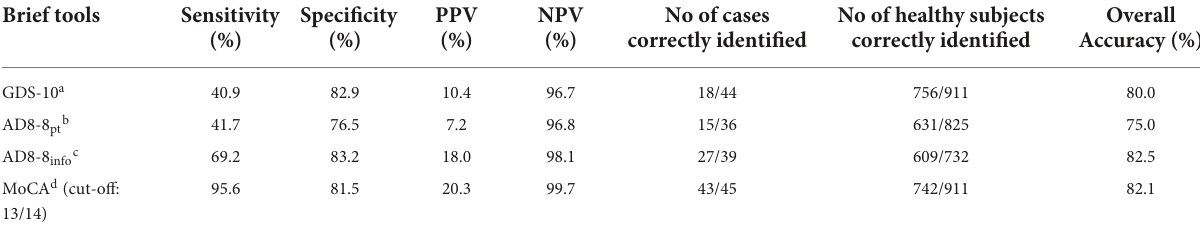
TABLE 2 Discriminant indices of the different tools for detecting dementia.